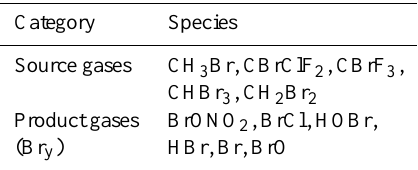
Table 1. Brominated species in full chemistry setup.